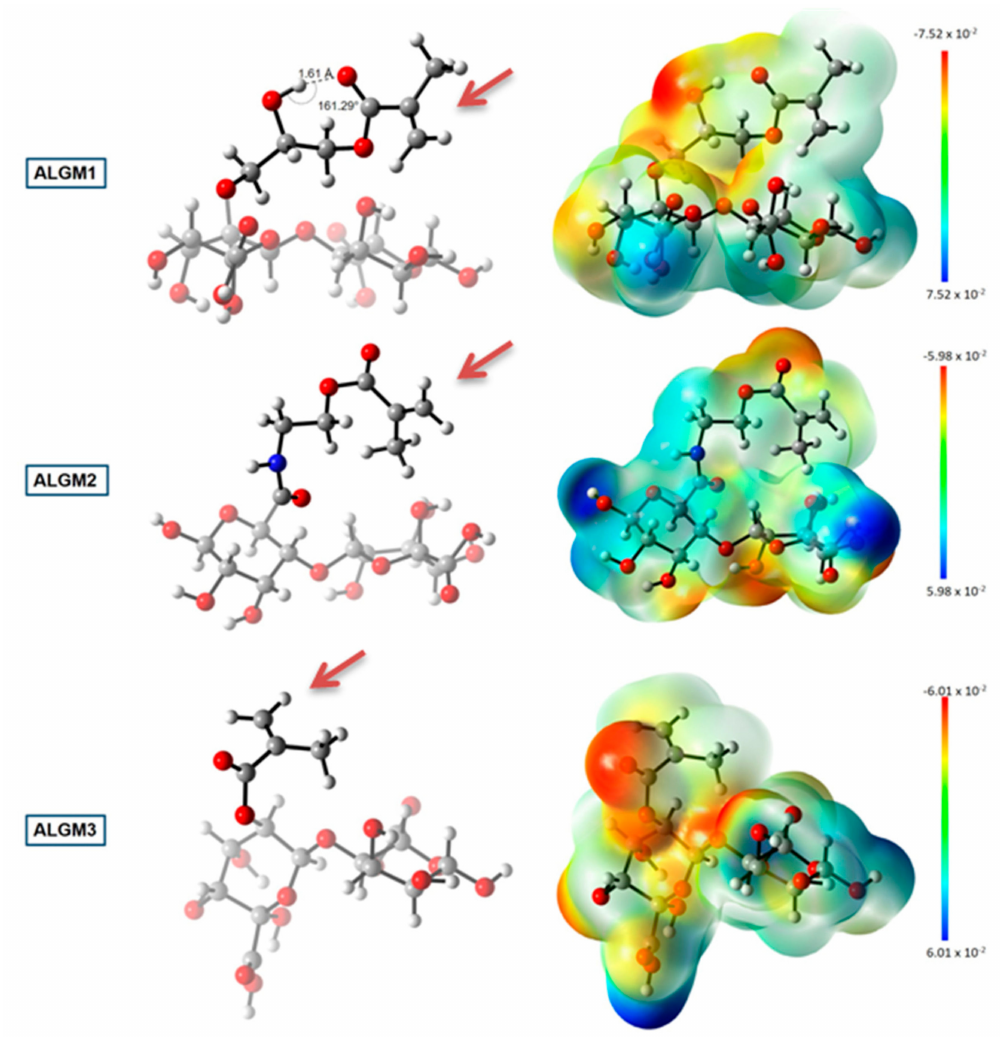
Figure 6. DFT calculations: geometry optimized structures (left) and electrostatic potential maps (right) of the ALGMx macromers. Carbon, hydrogen, oxygen, and nitrogen atoms are represented as gray, white, red, and blue spheres, respectively. Two sugar rings representing the ALG chain were considered in the calculations. The brown arrows mark the C = C reactive bonds. The bar at the far right of the image represents the color code of the isodensity surface. DFT coordinates and electronic energies are presented as Supplementary